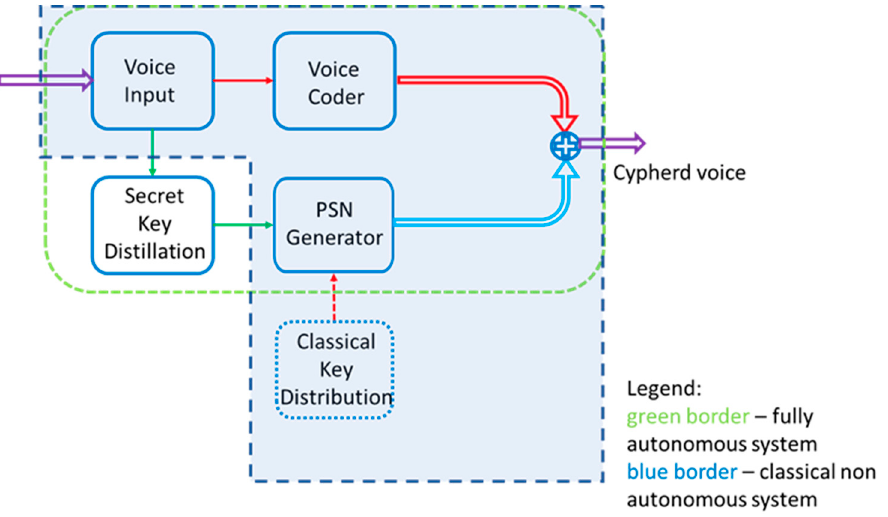
Figure 15. Concept of fully autonomous voice protection system. Green border lines indicate a classic system, while blue border lines indicate a fully autonomous system.